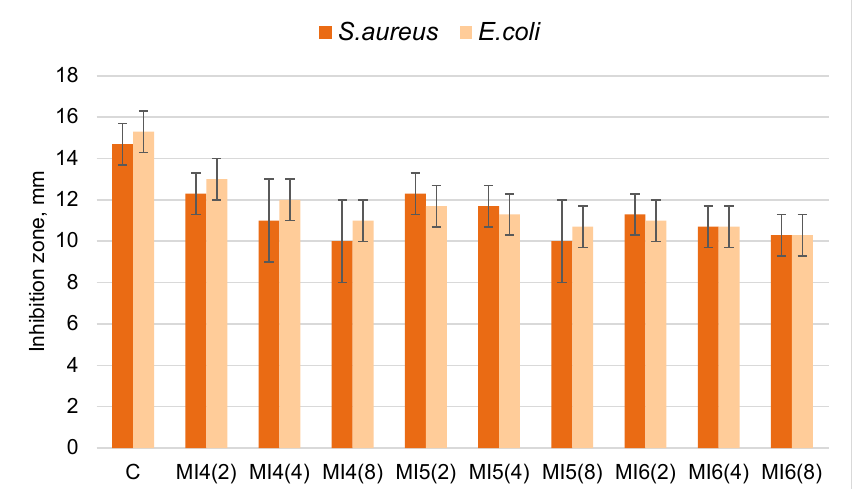
Figure 7. Diameters (mm) of inhibition zones against S. aureus and E. coli bacteria of modified cotton knitted fabric inserts used in reusable masks. C is the non-worn sample; MI4 (2), MI5 (2) and MI6 (2) after 2 h of wearing; MI4 (4), MI5 (4) and MI6 (4) after 4 h of wearing; MI4 (8), MI5 (8), and MI6 (8) after 8 h of wearing.